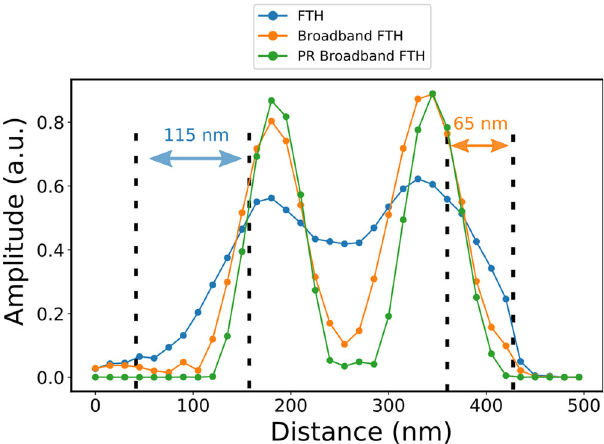
Fig. 4 Comparison of broadband with standard Fourier transform holography (FTH). Lineouts along the white-line in Fig. 3d (blue, standard FTH), Fig. 3e (orange, broadband FTH) and Fig. 5e (green, phase retrieval of the broadband FTH method). The achieved resolution was estimated using a knife-edge test on the standard Fourier transform holography (FTH) reconstruction and broadband FTH reconstruction. The amplitude is given in arbitrary units (a.u.).